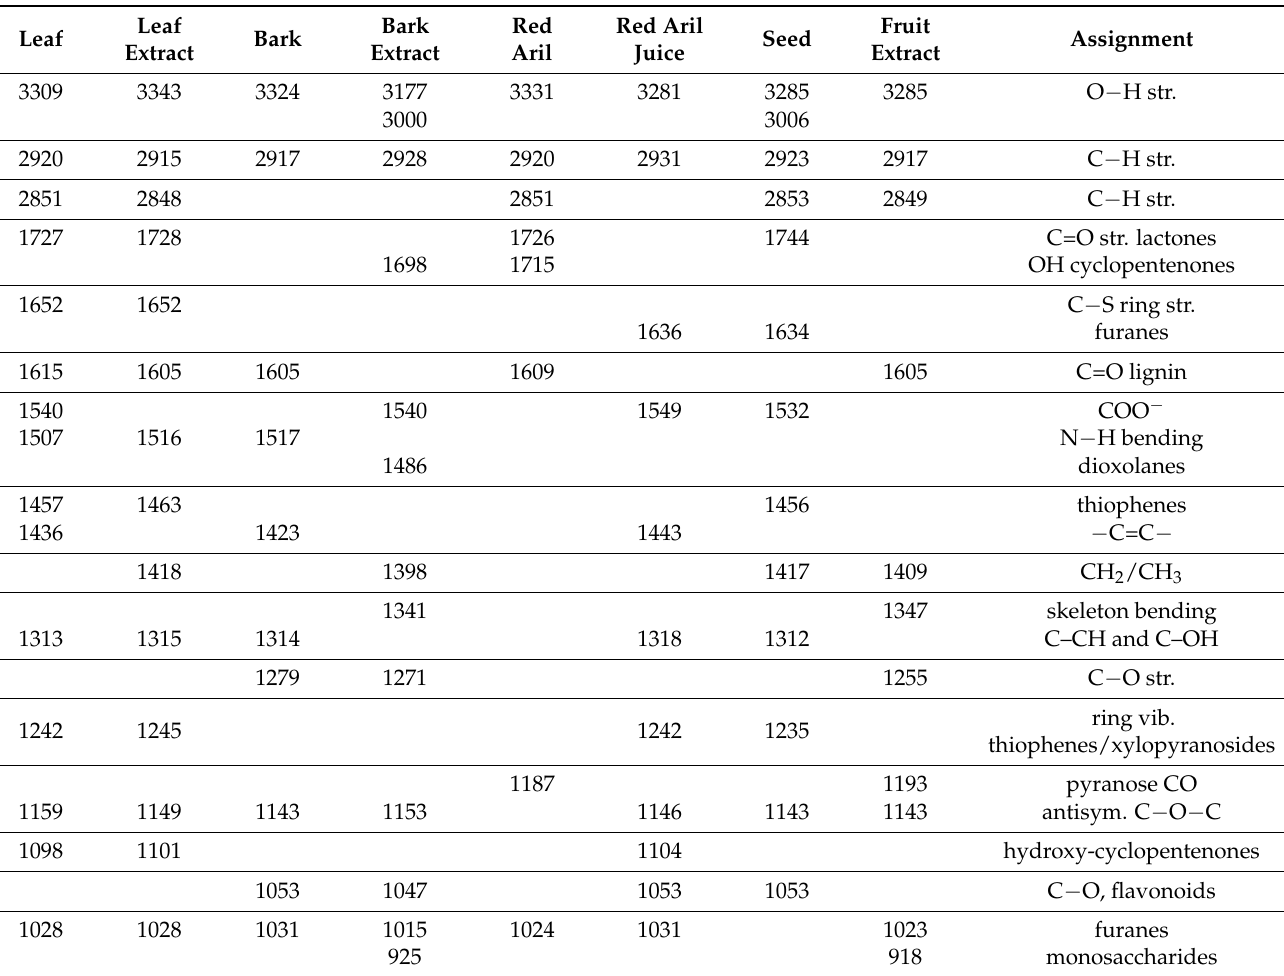
Table 1. Main bands in the infrared spectra of various plant organs of Taxus baccata and their freeze-dried extracts, together with their